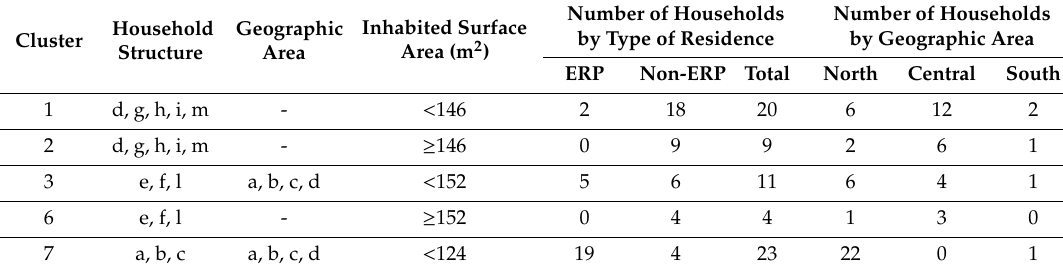
Table 5. Sociodemographic characterization of the clusters.